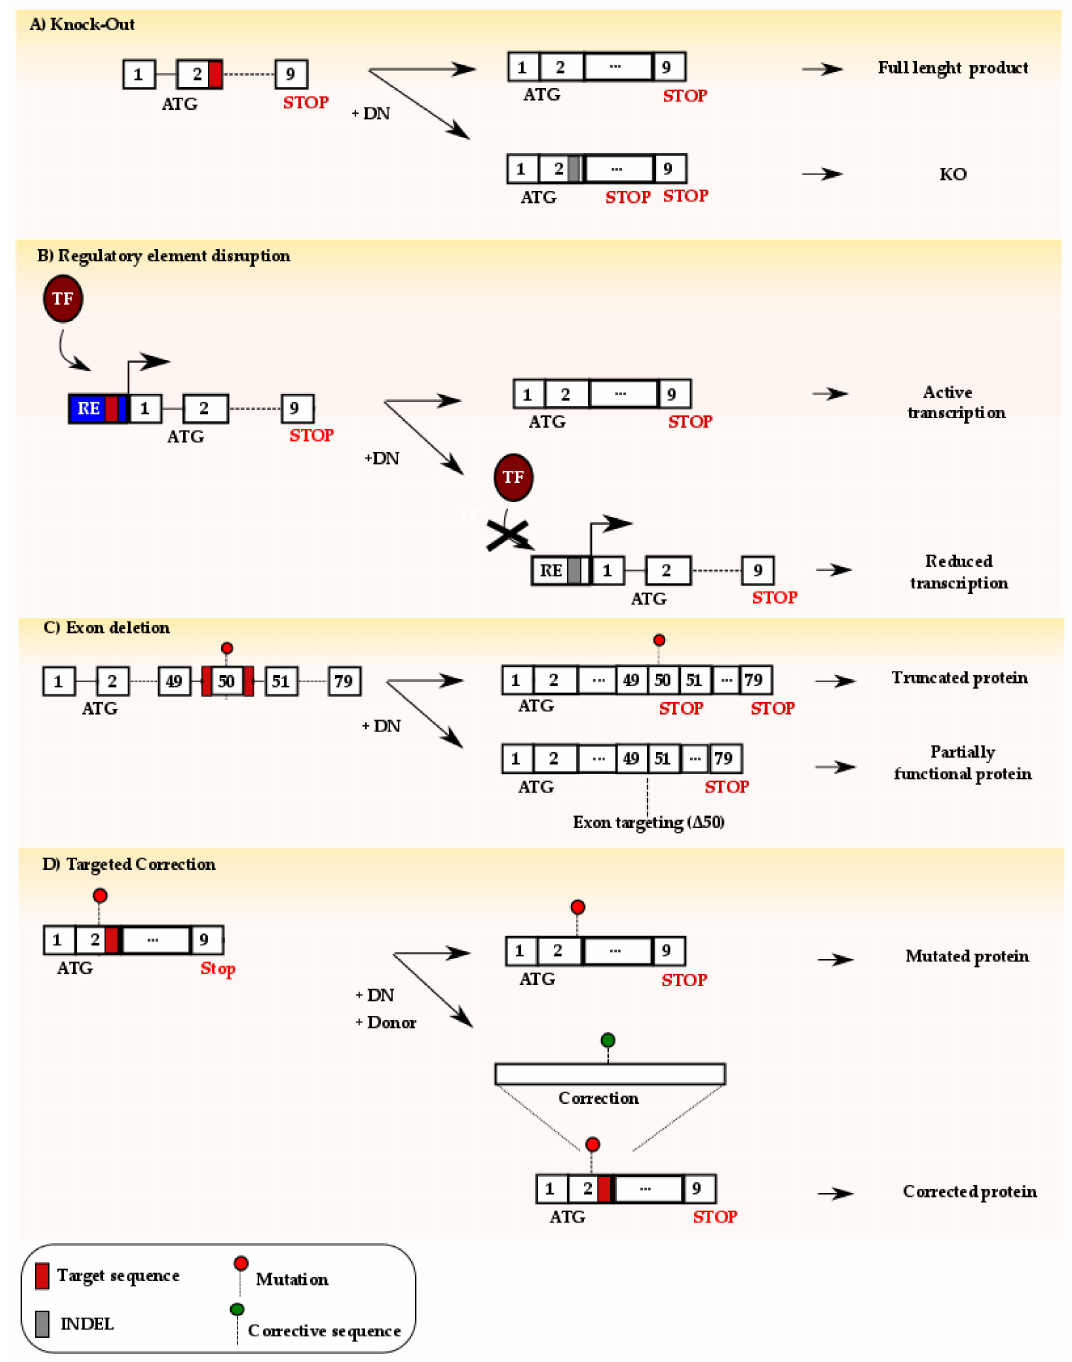
Figure 3. Genome editing using designer nucleases (DN): ( A ) Targeting of the DN to the coding region of a gene promotes the formation of a DSB which is typically repaired via NHEJ. The subsequent formation of indel mutations (grey box) may generate a premature stop codon, eventually leading to gene inactivation. ( B ) DN can be targeted to regulatory elements (RE) in order to disrupt the binding site of an activating transcription factor (TF). As a result, downstream gene transcription might be reduced or abolished in a cell-specific fashion as described in Section 6.1. ( C ) Two DNs can be directed to sites flanking an exon containing a non-sense mutation for its deletion. The resulting gene might result in the generation of a truncated, albeit partially functional, protein. ( D ) Targeting of a DN in proximity of a genetic mutation and simultaneous delivery of a donor template harboring the correct genetic sequence might result in precise gene editing via harnessing of the homology directed repair